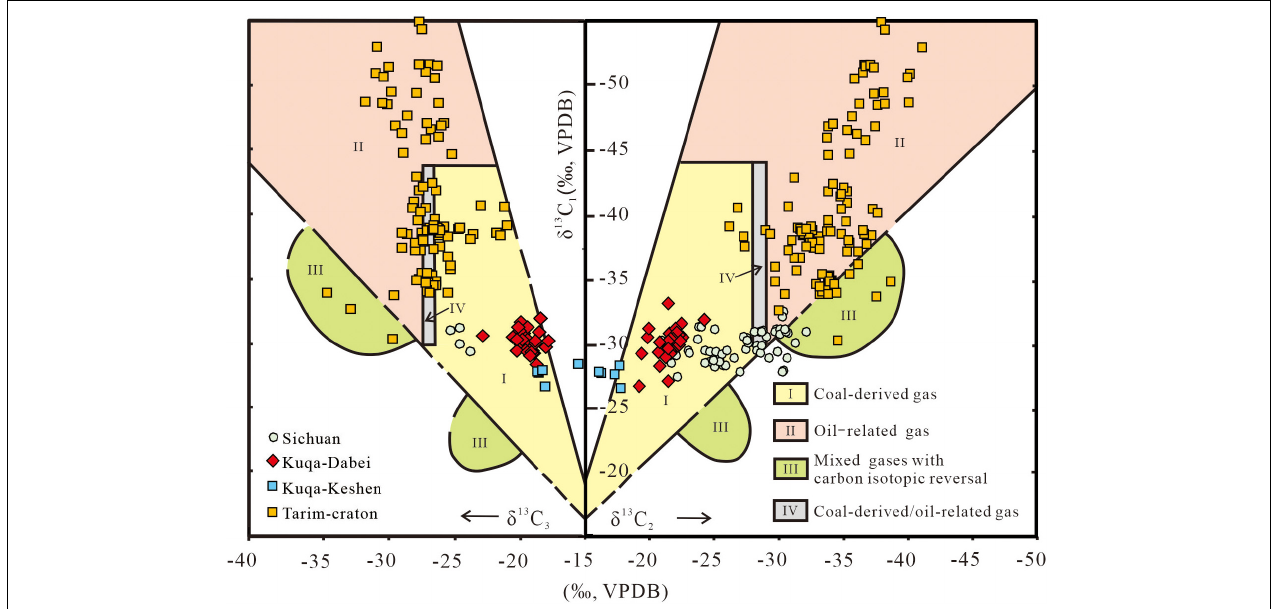
FIGURE 7 | Plot of δ 13 C 1 vs. δ 13 C 2 vs. δ 13 C 3 of gases from Dabei and Keshen gas fields in the Kuqa depression, craton area in the Tarim Basin, and Sichuan Basin (Dai et al., 1992). Data source see section “Samples and Methods” in the text.